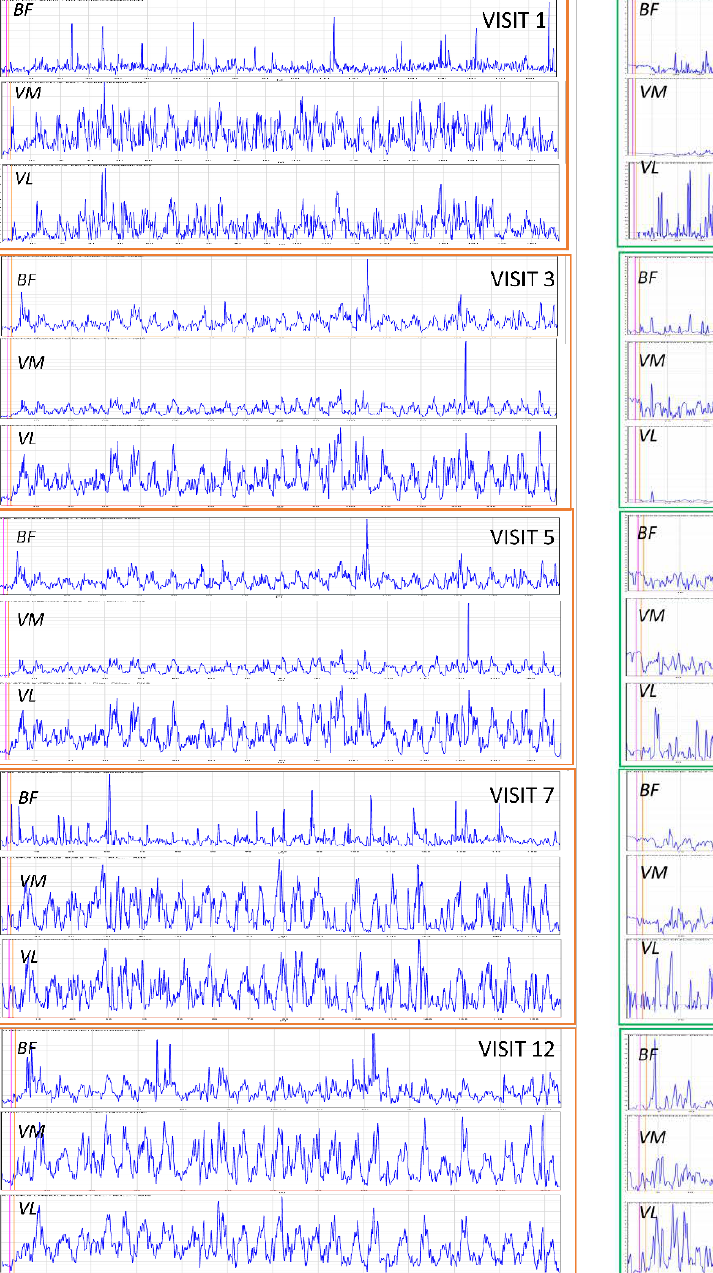
Figure 4 . Example Subject B’s EMG signals over the duration of the task for select lower-limb muscles (BF, biceps femoris; VM, vastus medialis; VL, vastus lateralis) during 5 visits spanning the initial 12 training sessions. Activation patterns tended to show more refined/consistent recruitment during later